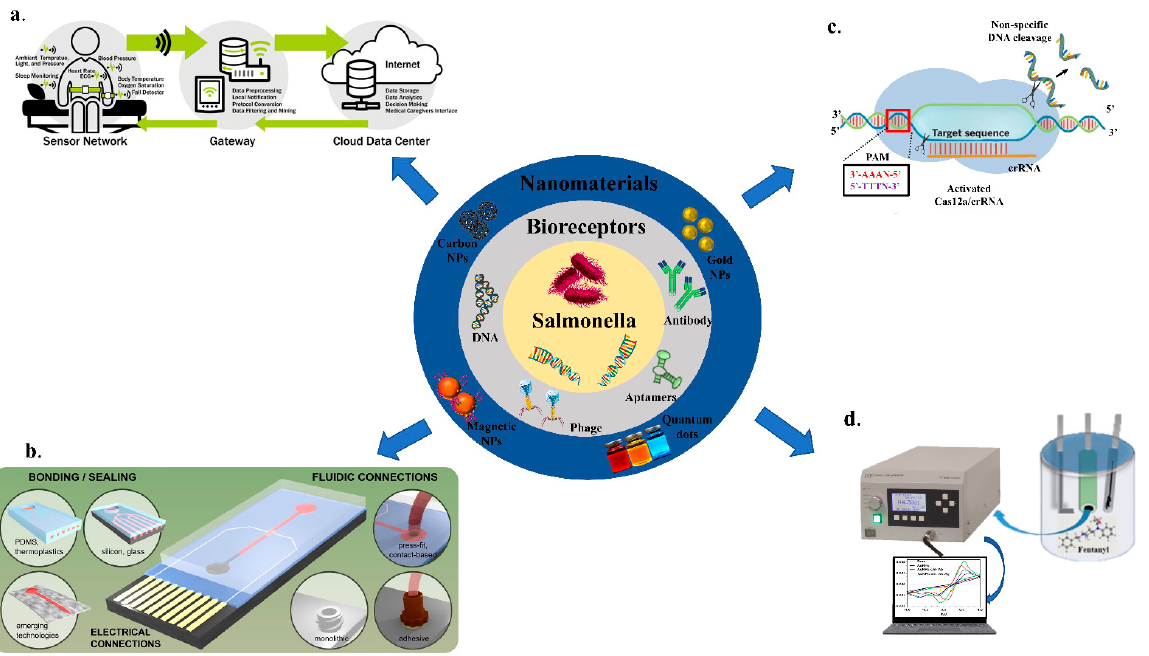
Figure 1. An overview of biosensors for the detection of Salmonella; ( a ) IOT-based; Adapted with permission from Ref. [17]. Copyright 2018, Elsevier. ( b ) Microfluidics based; Adapted with permission from Ref. [18]. Copyright 2015, Elsevier. ( c ) CRISPR/Cas-based; ( d ) Potentiometry-based biosensing.